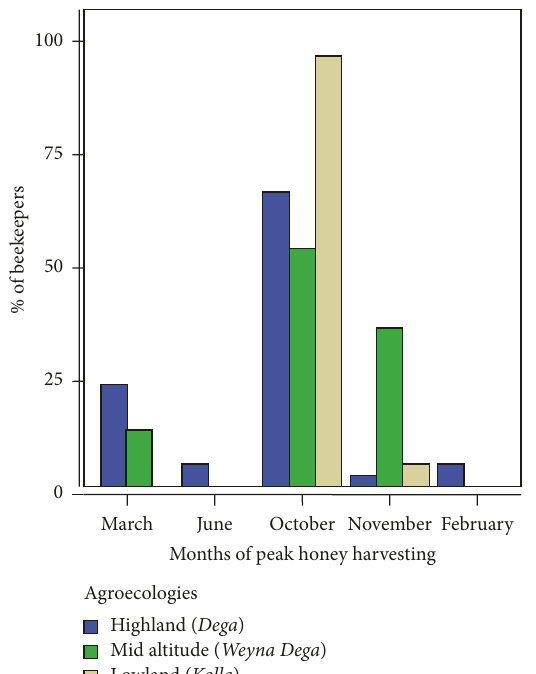
Figure 1: The peak honey harvesting periods in agroecological